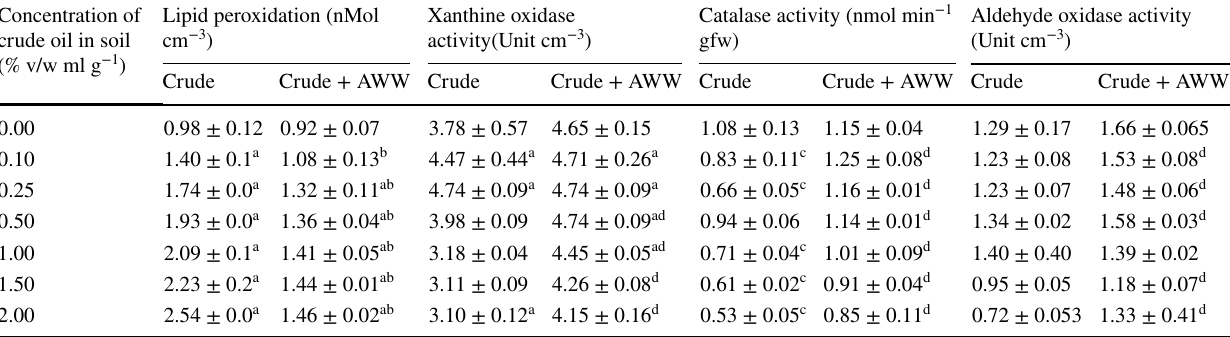
Table 4 Effect of abattoir wastewater treatment on lipid peroxidation and activities of xanthine oxidase, catalase and aldehyde oxidase in cowpea seedlings exposed to crude oil treated soil